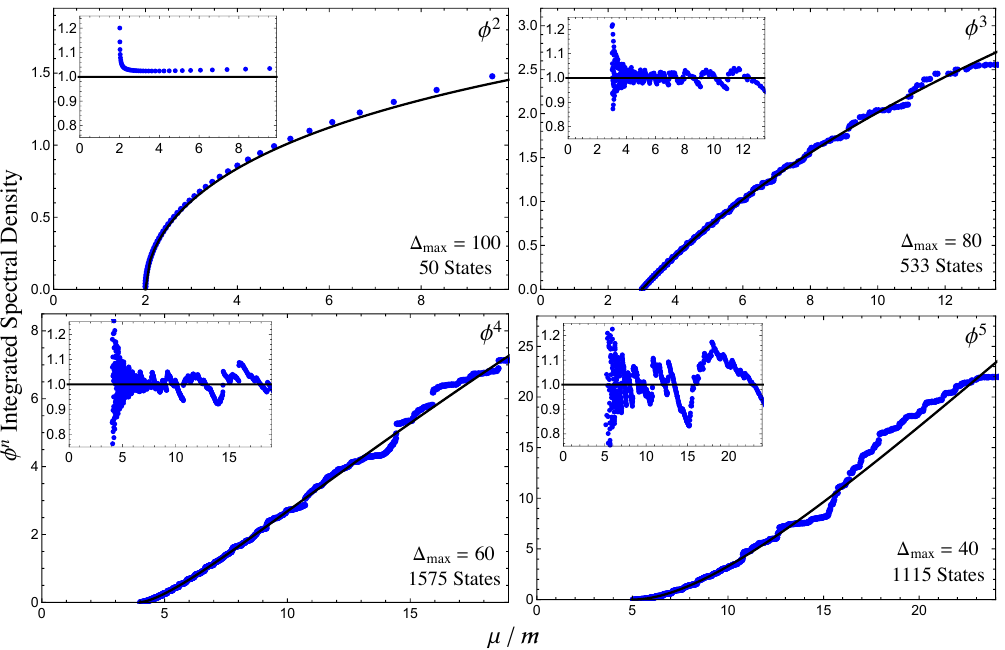
Figure 1 . Integrated spectral densities for (cid:30) 2 (upper left), (cid:30) 3 (upper right), (cid:30) 4 (lower left), and (cid:30) 5 (lower right) in massive free (cid:12)eld theory ((cid:22) (cid:21) = 0), both the raw value (main plot) and normalized by the theoretical prediction (inset). The conformal truncation results (blue dots) for each plot are computed using the (cid:1) max shown, with the corresponding number of n -particle basis states, and compared to the theoretical prediction (black